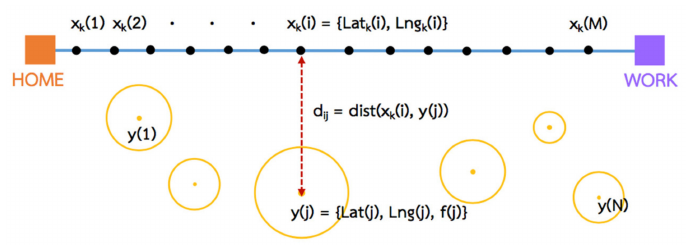
Figure 4. Illustrating graphics of distance calculation between a route choice and visited cell tower